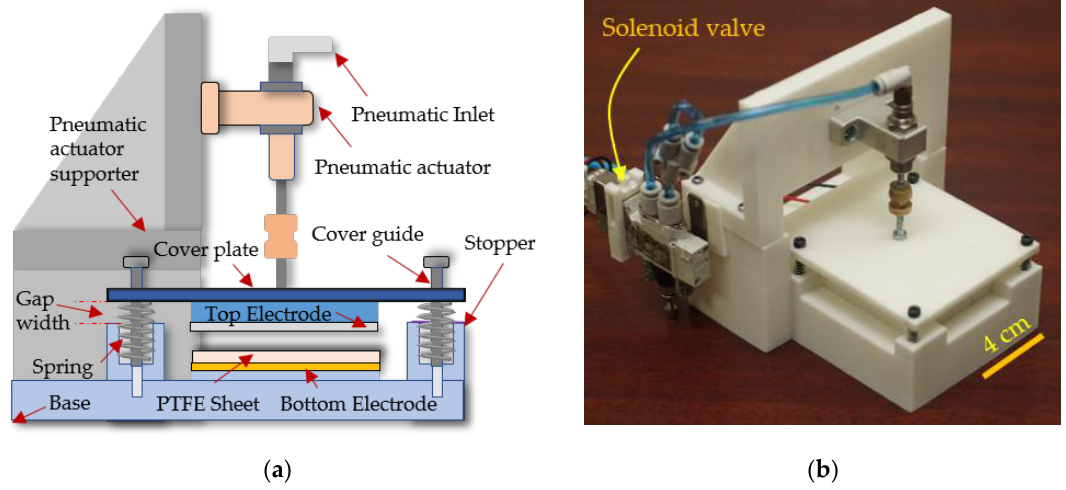
Figure 3. Triboelectric energy harvester (TEH) test bench: ( a ) Cross-section of TEH test bench; ( b ) Photograph of TEH test bench. PTFE,